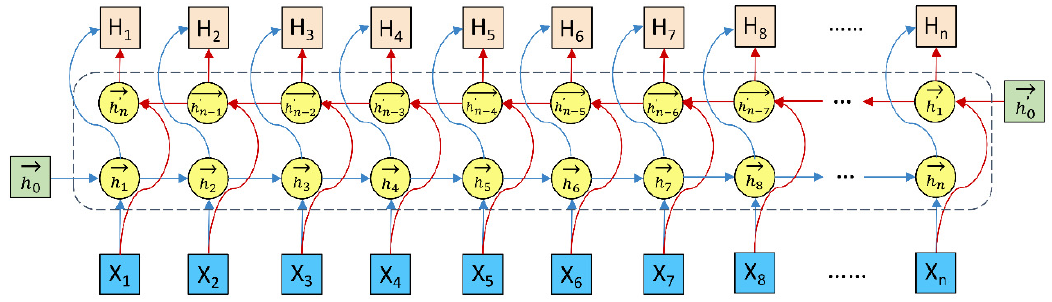
→ → h (cid:48) h i , , and H i denoted the input, the forward hidden n − i